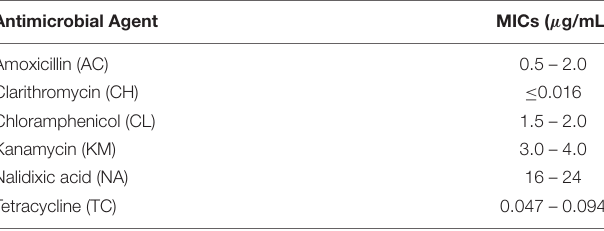
FIGURE 6 | Gross and hematoxylin and eosin (H&E) images from a Helicobacter qPCR-positive, gastric ulcer-positive adult male southern sea otter. (A) Severe pyloric mucosal erosions and ulcers with perilesional mucosal hemorrhage and melena. Most of the lesions are aligned along the tips and edges of rugal folds. (B) Microscopic view of pylorus showing focal expansion of pyloric lamina propria by nonsuppurative inflammation, in association with mild stromal collapse. H&E, Scale bar = 500 µ m. TABLE 2 | The minimum inhibitory concentrations (MICs) of Helicobacter enhydrae sp. nov (MIT 01-6242) against antimicrobial agents targeted toward bacteria like H. pylori .